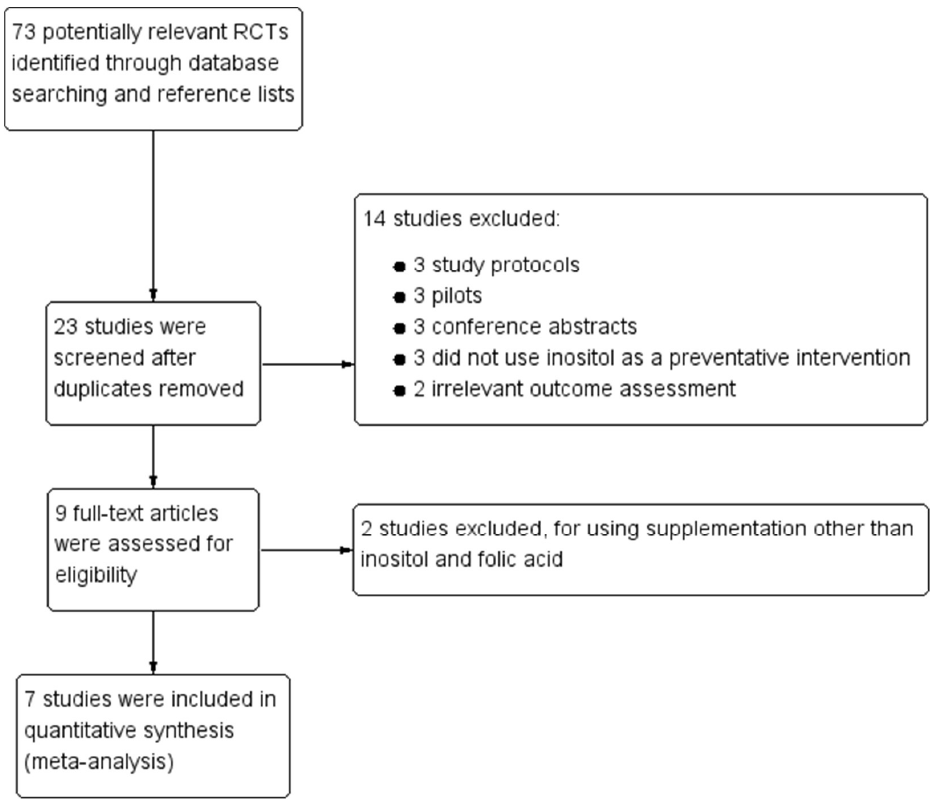
Figure 1. Flowchart of study search and selection.